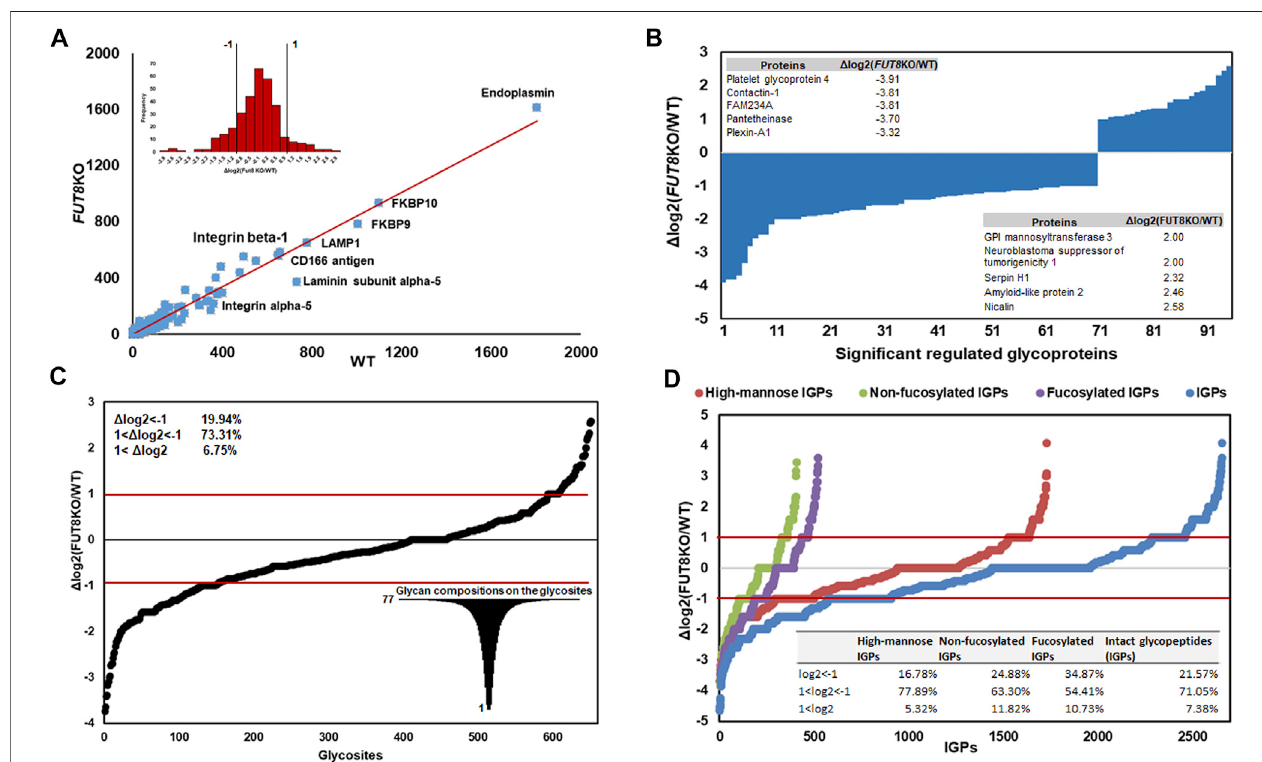
FIGURE2| QuantitativeanalysisofglycoproteinsinWTandFUT8KOCHOcells. (A) Relativeabundancescatteranddistributionpro fi lingofglycoproteinsbetween WT and FUT8KO CHO cells, showing a strong correlation between the WT and FUT8KO cells. (B) The ninety- fi ve signi fi cant regulated glycoproteins between WT and FUT8KO cells, the top fi ve up-regulated and down-regulated glycoproteins were also showed. (C) Differential glycosylation on the 652 glycosites between WT and FUT8KO cells. (D) Relative abundance distribution of sub-glycotypes of intact glycopeptides between WT and FUT8KO cells.